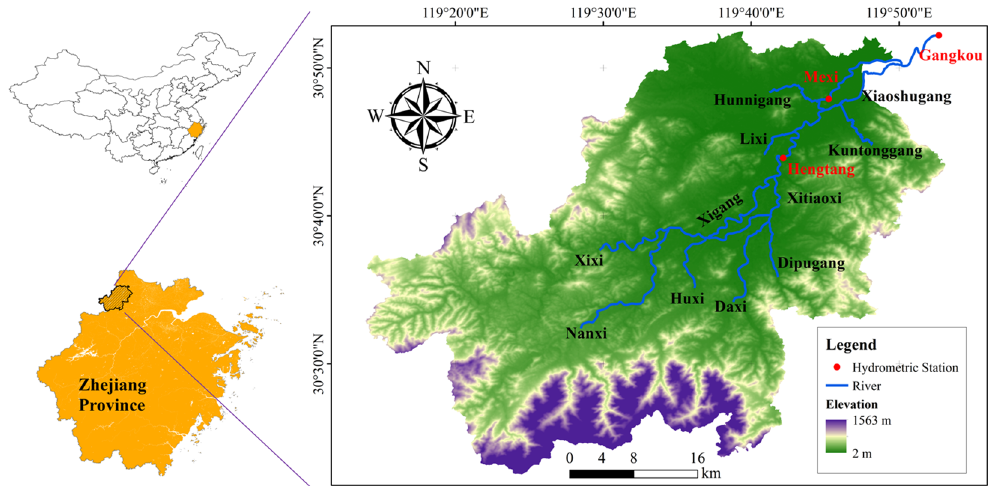
Figure 1. Topography and water system in Anji County.